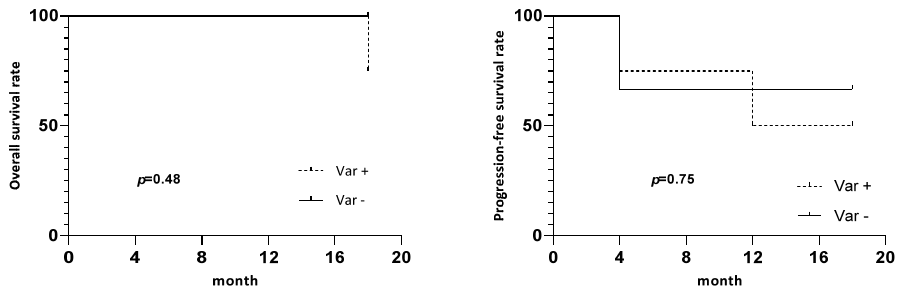
Figure 3. Survival curves. Overall survival and progression-free survival of patients depending on CTC’s variation between baseline and day 21. Var +: positive variation of CTCs, Var -: no positive variation.